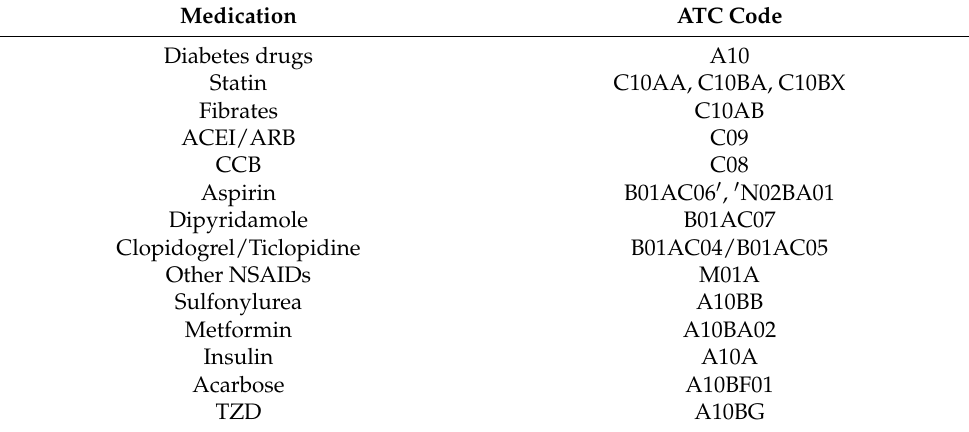
Table A2. Anatomical Therapeutic Chemical (ATC) Classification codes used for medications in our